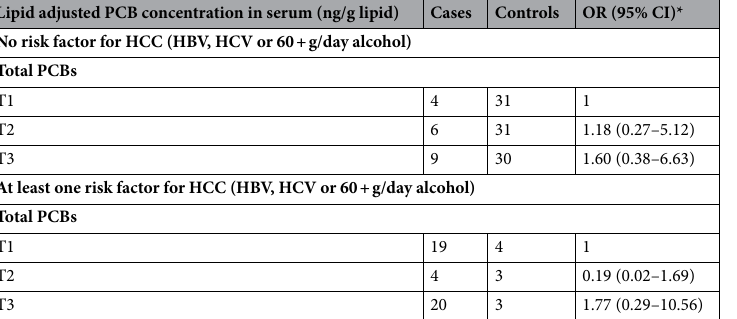
Table 5. Odds ratios (ORs) for hepatocellular carcinoma (HCC) for total polychlorinated biphenyls by HCC risk factors, according to distribution tertiles of polychlorinated biphenyls (PCBs) in the controls. *Adjusted for age, sex and residence by logistic regression